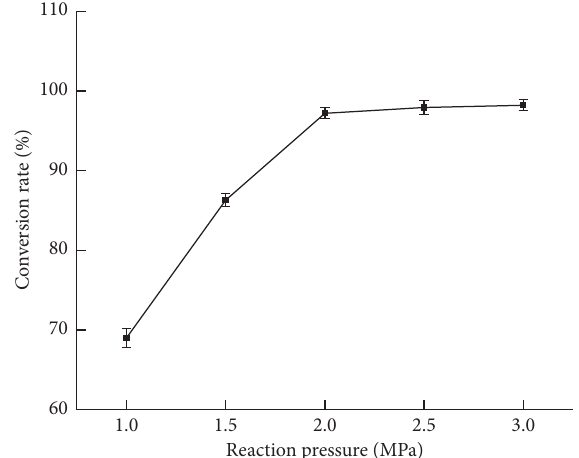
Figure 9: Effects of reaction pressure on the conversion rate of unsaturated components.